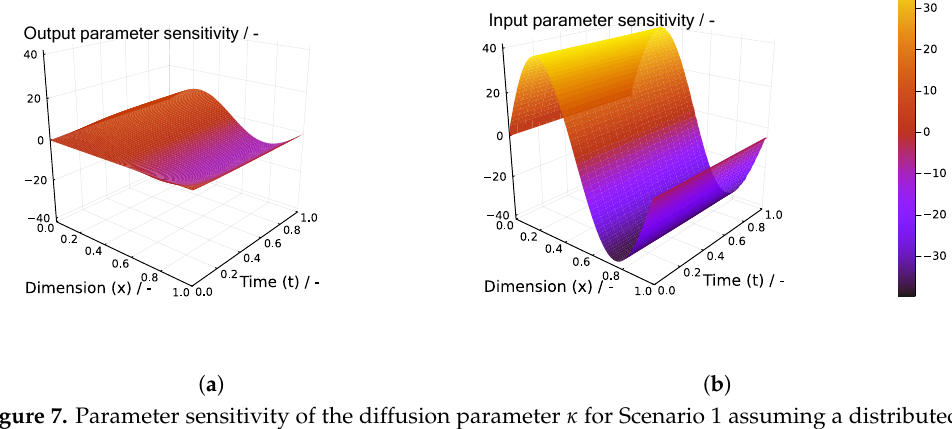
Figure 7. Parameter sensitivity of the diffusion parameter κ for Scenario 1 assuming a distributed control problem with ( a ) using OLS to define the parameter identification problem and ( b ) where ILS is used to define the parameter identification problem